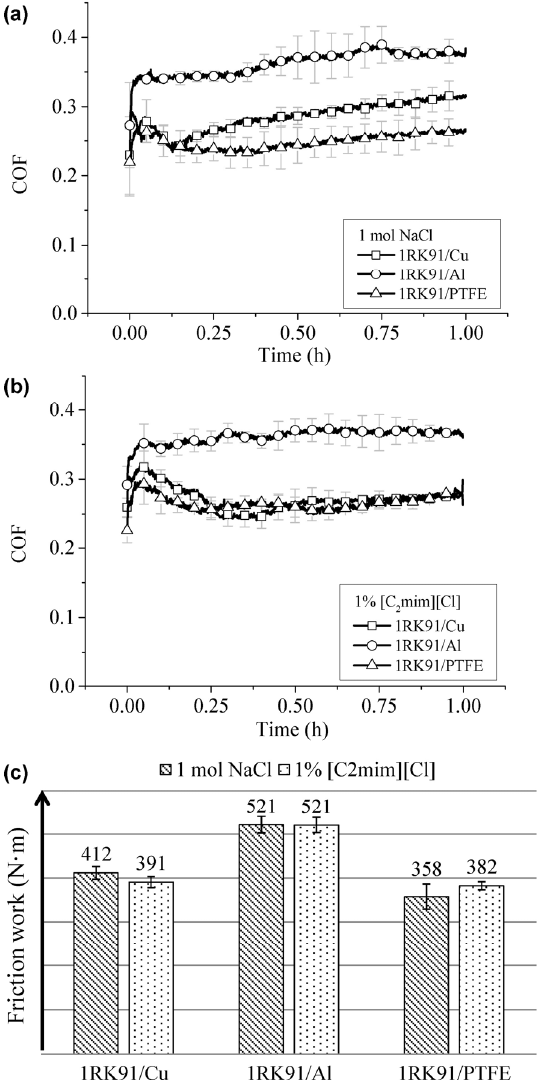
Fig. 3 Mean value of the coefficient of friction using different material combinations with 1 molar NaCl (a) and 1% [C 2 mim][Cl] (b) as electrolyte. (c) Overview of the mean value of the friction work using different material combinations with 1 molar NaCl and 1% [C 2 mim][Cl] as